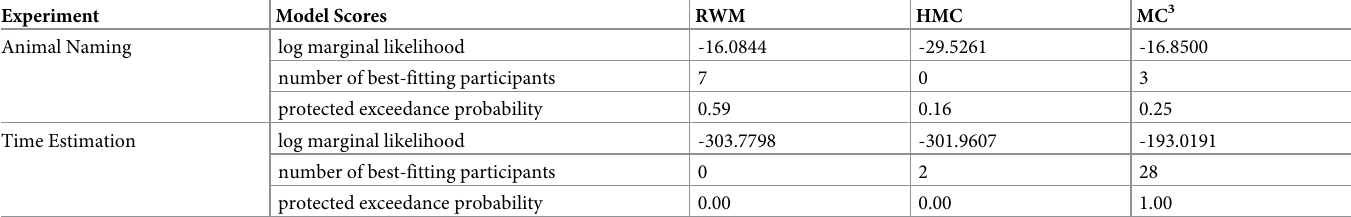
Table 1. Model scores for the three sampling algorithms: Random Walk Metropolis (RWM), Hamiltonian Monte Carlo (HMC), and Metropolis-coupled Markov Chain Monte Carlo (MC 3 ).